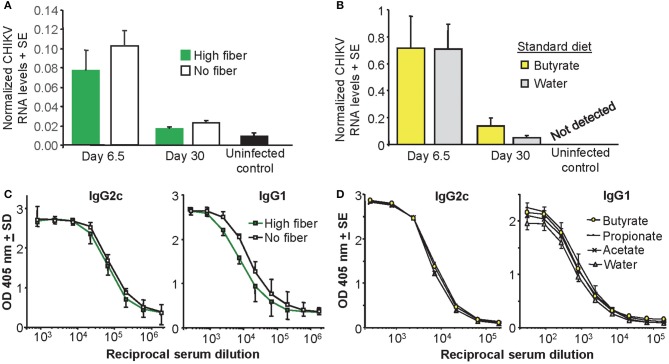
Viral loads and antibody responses. (A) Mice were fed on a high fiber or a no fiber diet for 3 weeks and were then infected with CHIKV (or left uninfected as controls). On day 6.5 and day 30 post infection feet were analyzed for CHIKV RNA by qRT PCR. Diet did not significantly affect CHIKV RNA levels (n = 4 mice and feet per group). (B) Mice were fed on a standard fiber and water was supplemented with butyrate or left unsupplemented (Water) and after 3 weeks mice were infected with CHIKV (or left uninfected as controls). Butyrate did not significant affect CHIKV RNA levels (n = 6 mice and feet per group). (C) Mice fed as for (A) with serum taken on day 30 post infection and assayed by ELISA for anti-CHIKV IgG2c or IgG1 antibody levels (n = 6 per group). (D) Mice with water supplementation as in (B), with serum taken on day 30 post infection and assayed by ELISA for anti-CHIKV IgG2c or IgG1 antibody levels (n = 6 per group).